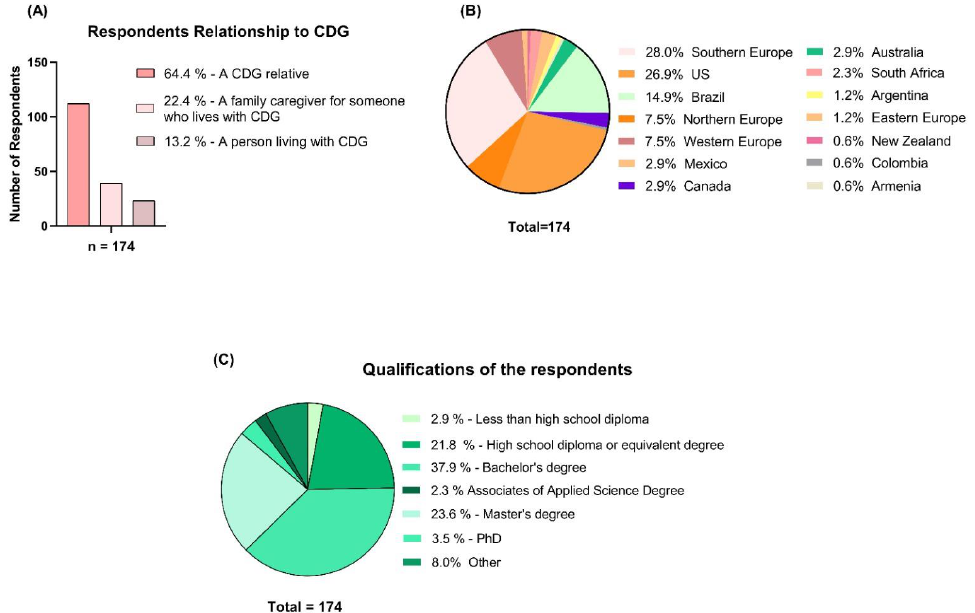
Figure 3. Socio-demographical characterization of the CDG Journey Mapping e-questionnaire respondents included in this study (CDG family members and caregivers). ( A ) Respondents’ relationship with CDG. ( B ) Geographical distribution of the respondents (per country of residence). ( C ) Family and caregivers’ academic qualifications.